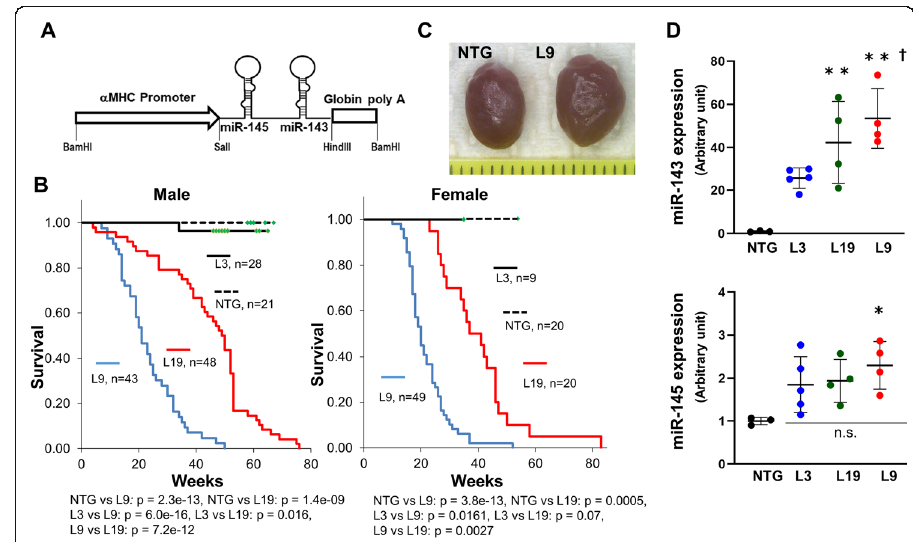
Fig. 1 Establishment of α MHC/miR-143/145TG mice. a Structure of the injected fragment. An approximately 6.7-kb Bam HI fragment containing the pri-miR-145 and pri-miR-143 genes was used. b Kaplan-Meier survival analysis of α MHC/miR-143/145TG mice. Data were analyzed using a log-rank test followed by a post hoc Holm test. Green squares = censored. c Hearts from representative 5-month old male NTG and L9 mice. The scale bar is 1 mm. d Quantitative RT-PCR analysis of miR-143 and miR-145 in the hearts of 3-month old male α MHC/miR-143/145TG mice. The results are presented as the means ± SD with scattered blots. Significance was assessed with one-way ANOVA followed by a post hoc Tukey test ( n = 3 ~ 5. * p < 0.05